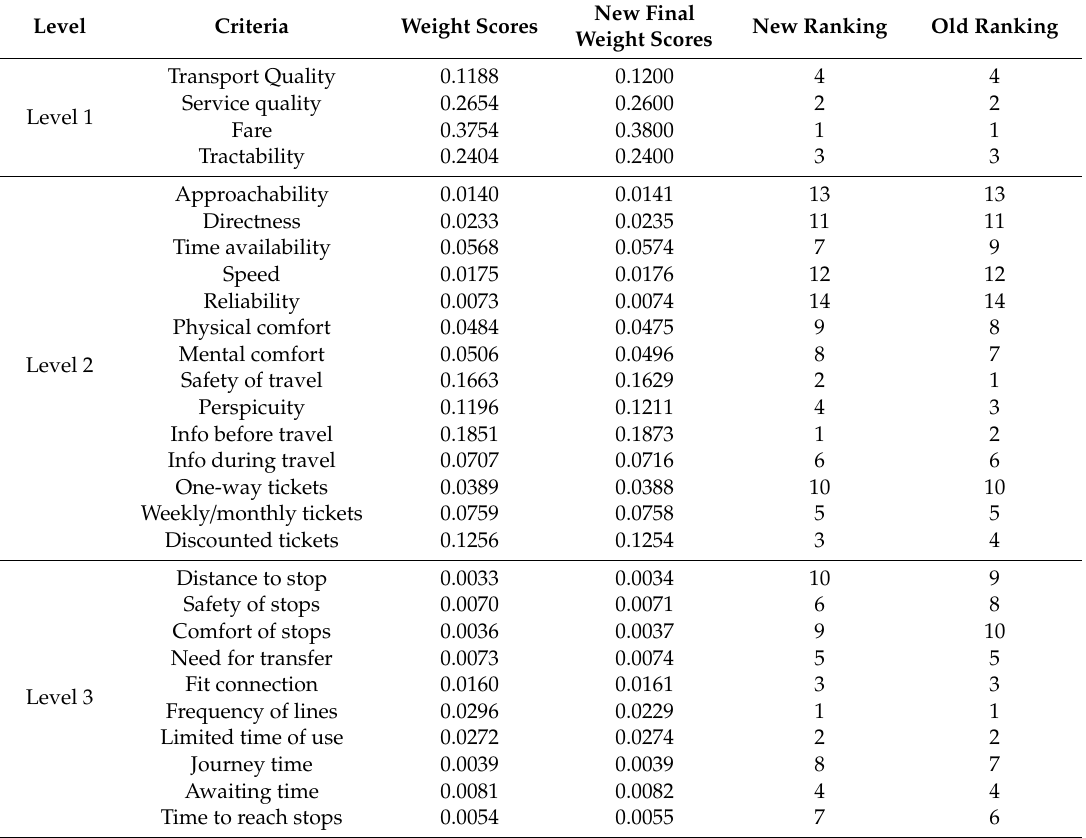
Table 11. Weight scores and ranking after the sensitivity check for the public transport experts